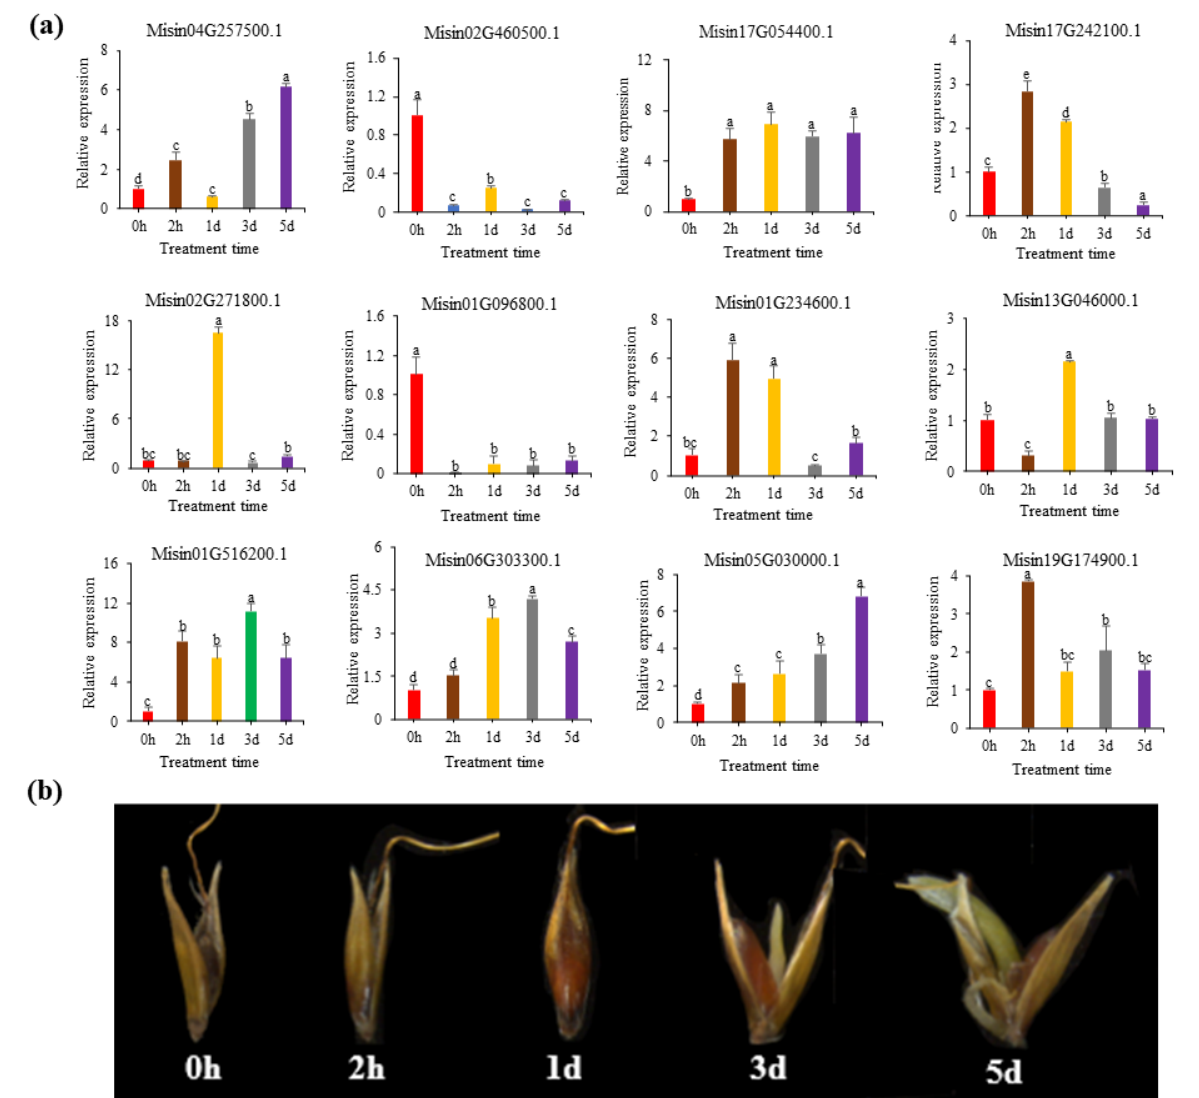
Figure 6. ( a ) Expression patterns of 12 HD-Zip genes from M. sinensis related to seed germination chosen at random. The gene Unigene33024 has been used to standardize all the data. Significant differences ( p < 0.05) between the treatments were denoted by lowercase letter(s) above all the bars. ( b ) Seed morphological changes during seed germination.